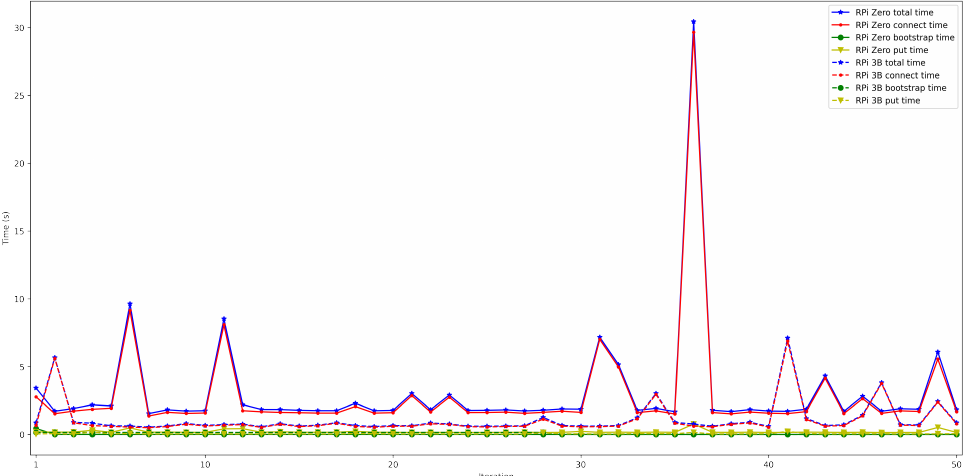
Figure 16. Latency when using Raspberry Pi Zero/3B+ gateways for 50 peers connected to the bootstrap node.